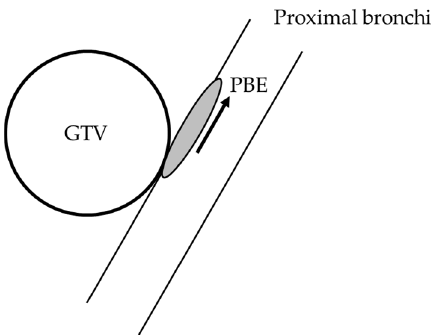
Figure 2. A schematic figure illustrating the GTV-to-CTV margin for microscopic PBE. GTV, gross tumor volume; CTV, clinical target volume; PBE, proximal bronchial extension.